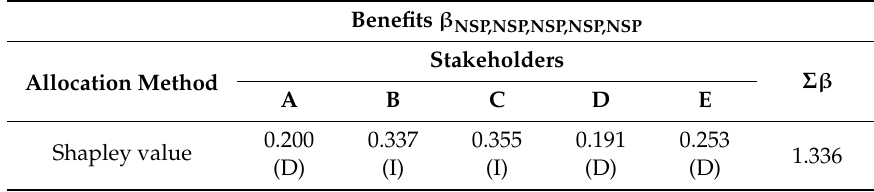
Table 14. Shapley value results for the benefits of stakeholders.